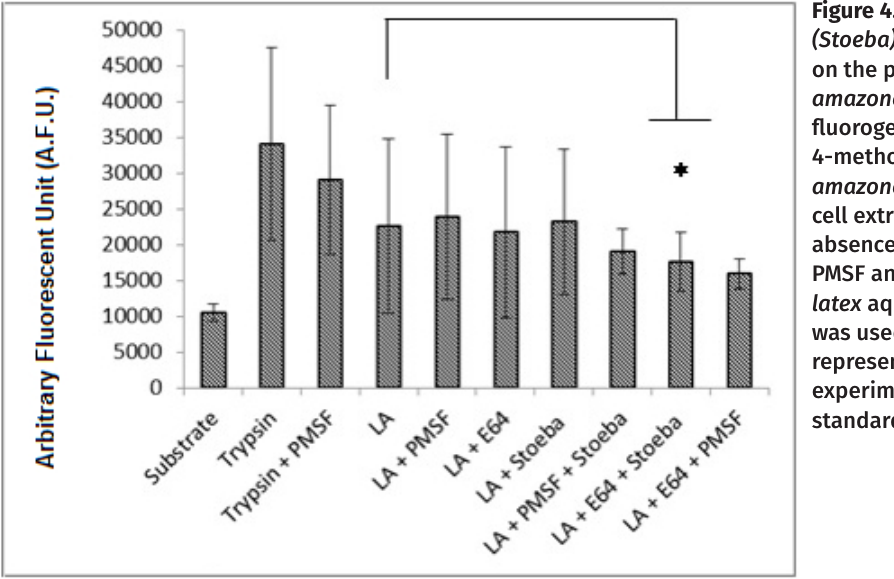
Figure 4. Effect of Dercitus (Stoeba) latex aqueous extract on the proteolytic activity of L. amazonensis . Hydrolysis of the fluorogenic substrate Z-Phe-Arg 4-methoxy-β-naphthylamide by L.